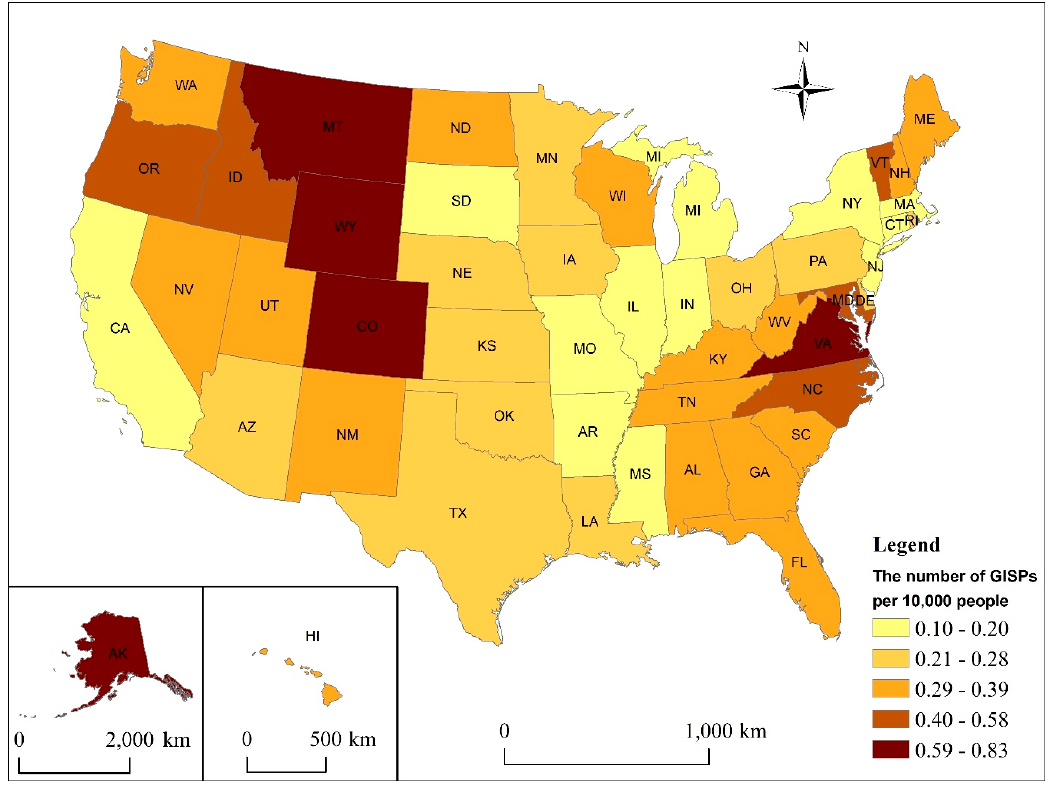
Figure 9. The number of GISPs per 10,000 people in the U.S.